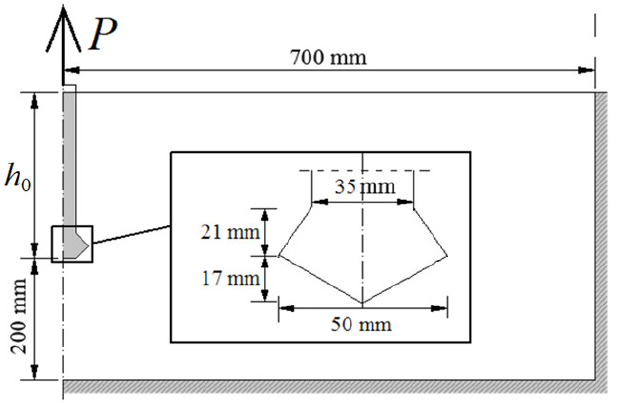
Figure 16. The scheme of simulating the pull-out test. Figure 14. The scheme of simulating the pull-out test.